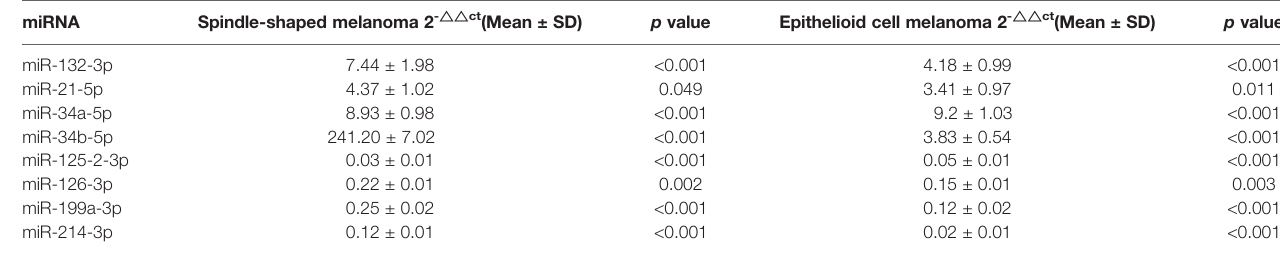
TABLE 1 | The results of real-time quantitative PCR performed on UM tissue samples.